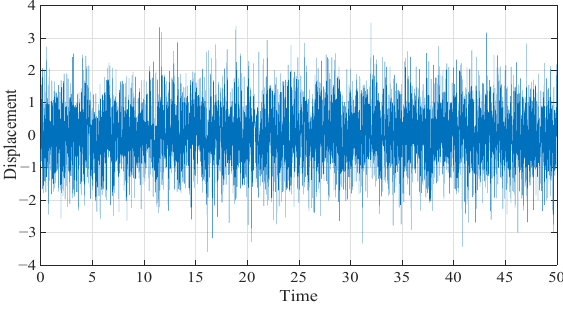
Figure 14. Random force excitation. Table 4. The variances and decrease ratios of the displacements of the primary system. Model of